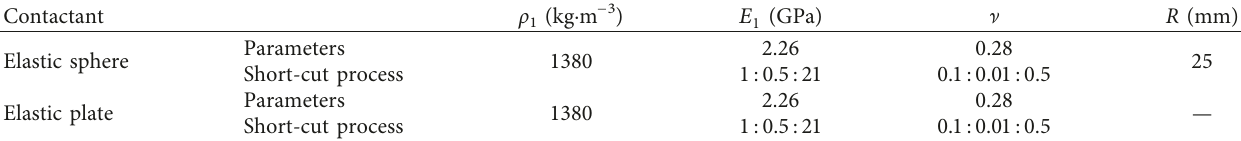
Table 5: Parameters of contact model of the elastic sphere and metal plate with same properties.